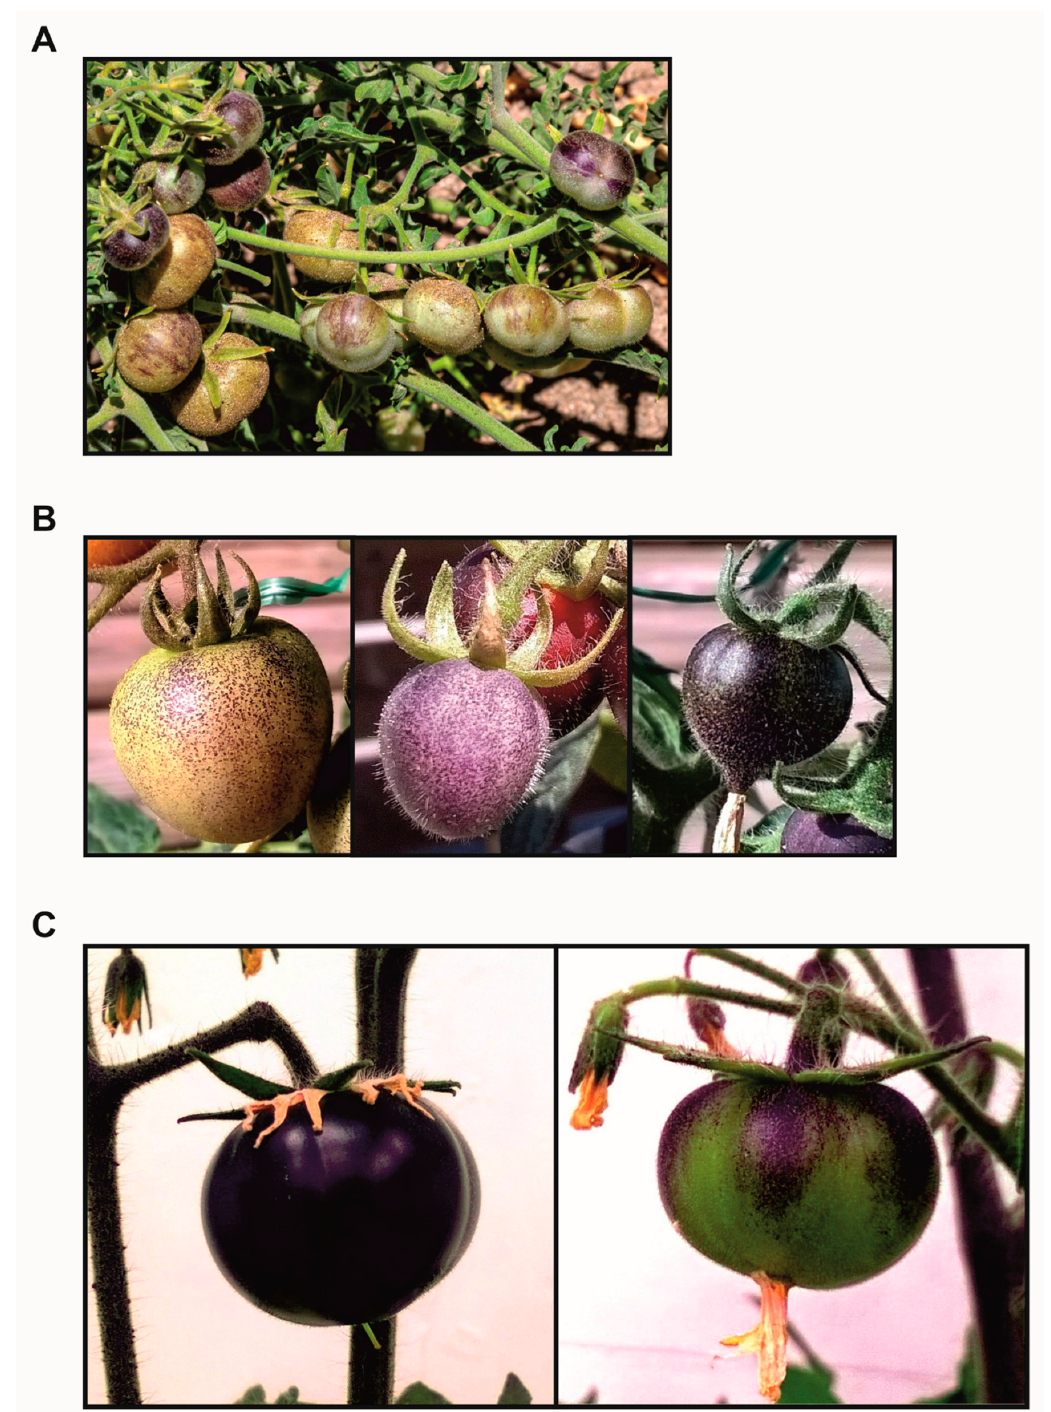
Figure 3. ( A ) Photo of Solanum chilense anthocyanin-spotted green ripe fruits from plants spontaneously grown in Chile, Toconao, Quebrada de Jere ( − 23.14553°, − 067.98998°, 2703 m, 12 dec 2012). ( B ) SLL fruits, cv. MicroTom, showing different levels of anthocyanin pigmentation at the mature green stage of ripening. From left to right: Aft / Aft x ATV / atv , Aft / Aft x atv / atv , and Aft / Aft x atv / atv x hp2 / hp2 genotypes. ( C ) SLL fruits, cv. Ailsa Craig, at mature green with Aft / Aft x atv / atv genotype, and complete or partial anthocyanin